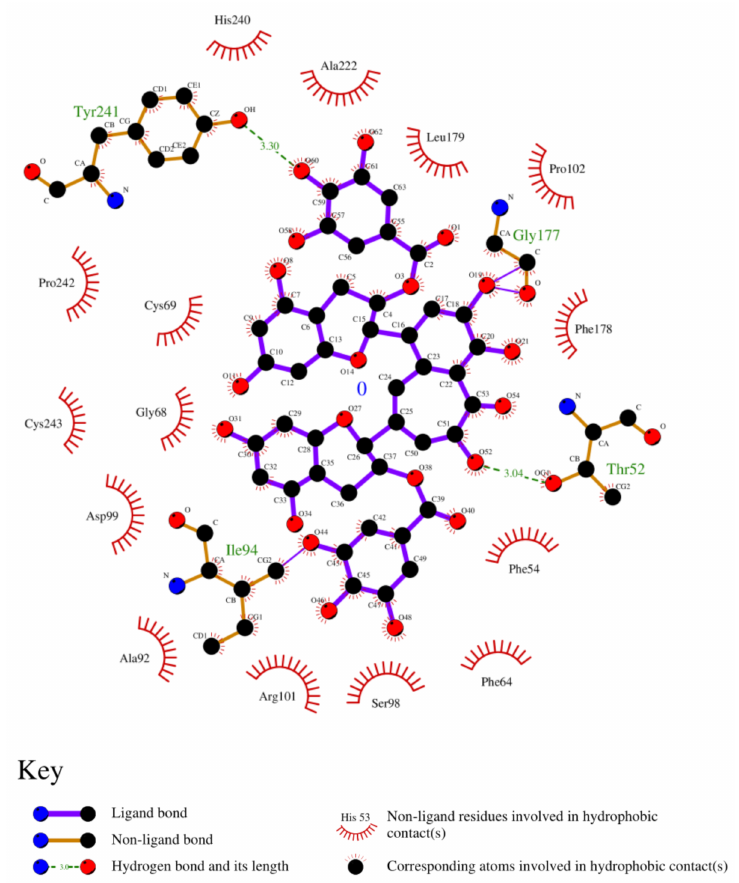
Figure 12. 2D interaction of [(2R,3R)-2-[2-[6-[(2R,3R)-5,7-dihydroxy-3-(3,4,5-trihydroxybenzoyl)oxy- 3,4-dihydro-2H-chromen-2-yl]-2,3,4-trihydroxyphenyl]-3,4,5-trihydroxyphenyl]-5,7-dihydroxy-3,4- dihydro-2H-chromen-3-yl] 3,4,5-trihydroxybenzoate and HCV E2